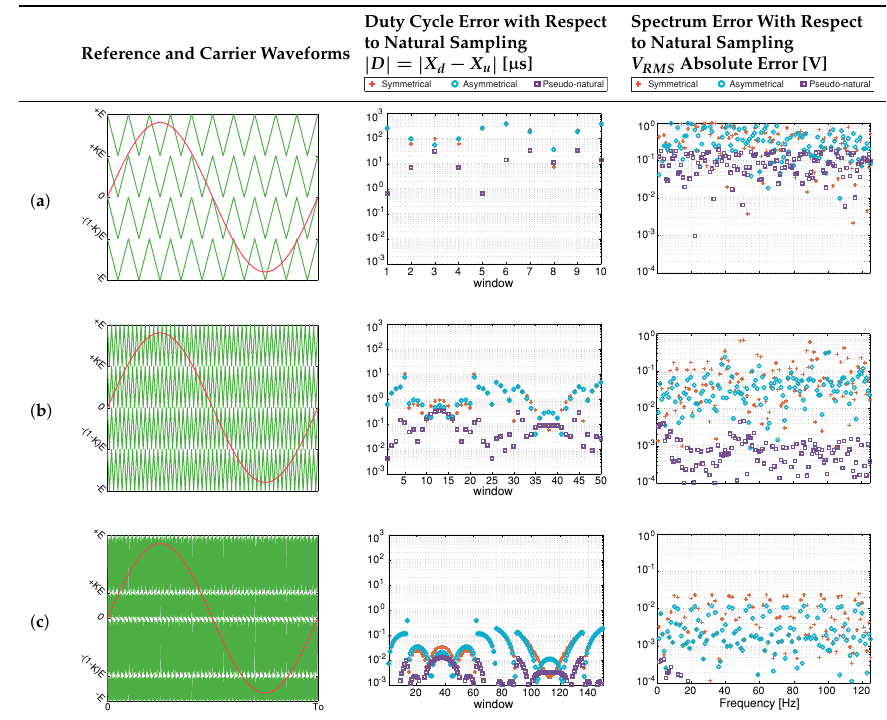
Table 4. Comparison of sampling methods in the time and frequency domains: Regular symmetrical, regular asymmetrical, and pseudo-natural against natural sampling with PD-SPWM, E = 50 V, K = 0.5, M a = 0.9, and r 1 = r 2 = r 3 = r 4 = 0.5 for ( a ) M f = 10, ( b ) M f = 50, and ( c ) M f =